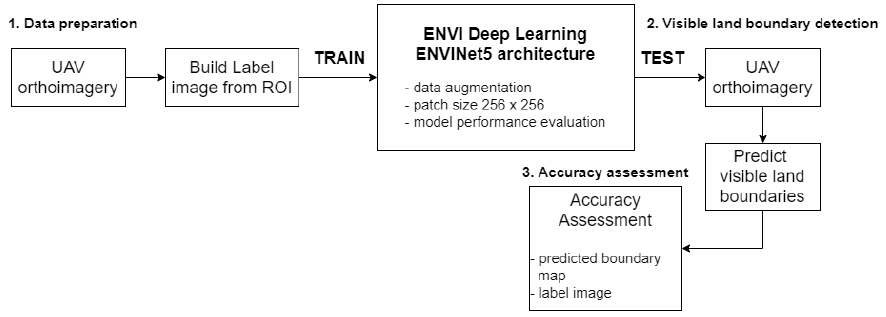
Figure 4. Workflow for the detection of visible land boundaries based on the ENVINet5 model.